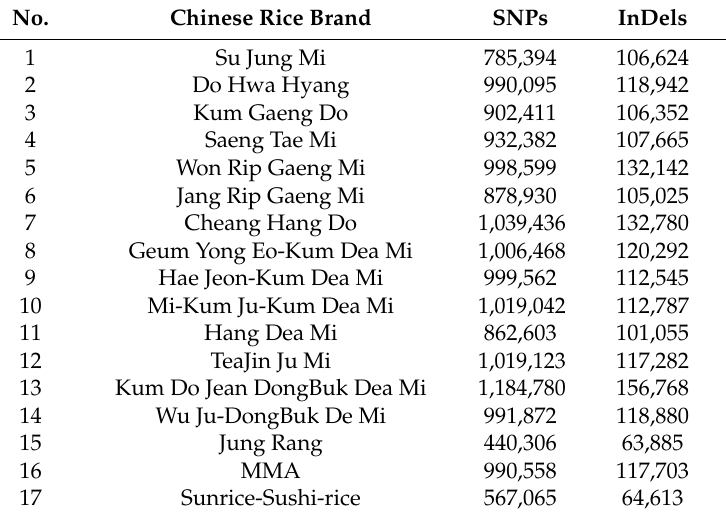
Table 2. Number of SNPs and InDels compared to the reference genome (IRGSP v. 1.0) detected in the 17 Chinese rice